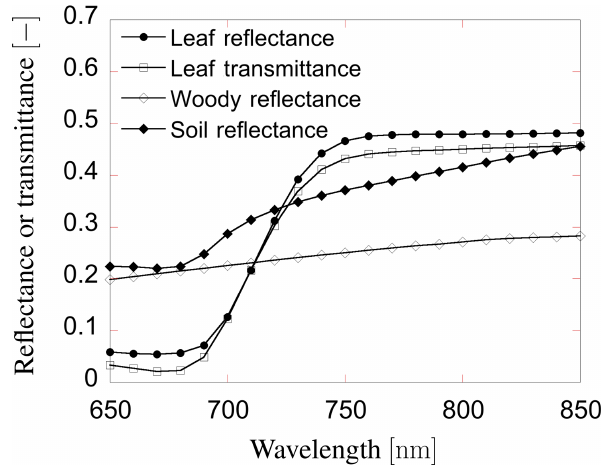
Figure 7. The fraction of SIF emission from adaxial and abaxial side of leaves. This ratio was determined by the leaf-level chloro- phyll fluorescence model (the FluorMODleaf model (FluorMOD-